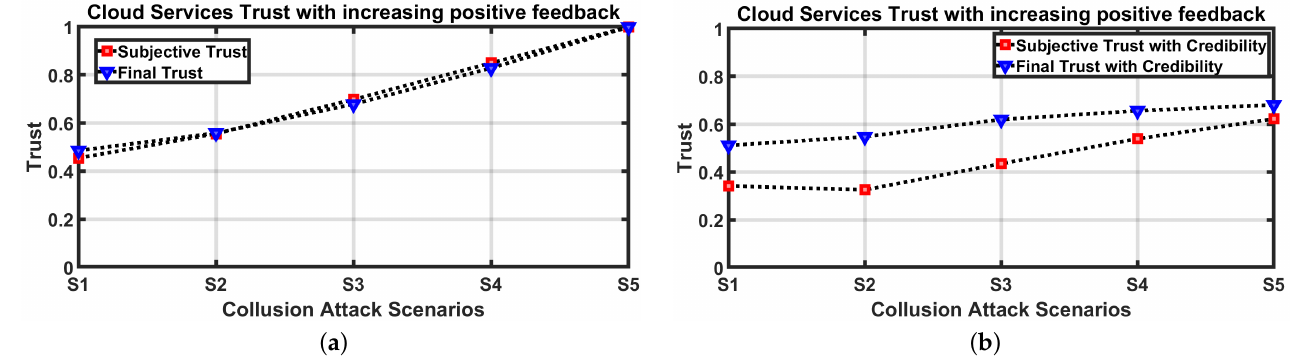
Figure 5. Comparative Analysis: ( a ) Final Trust and ( b ) Final Trust with